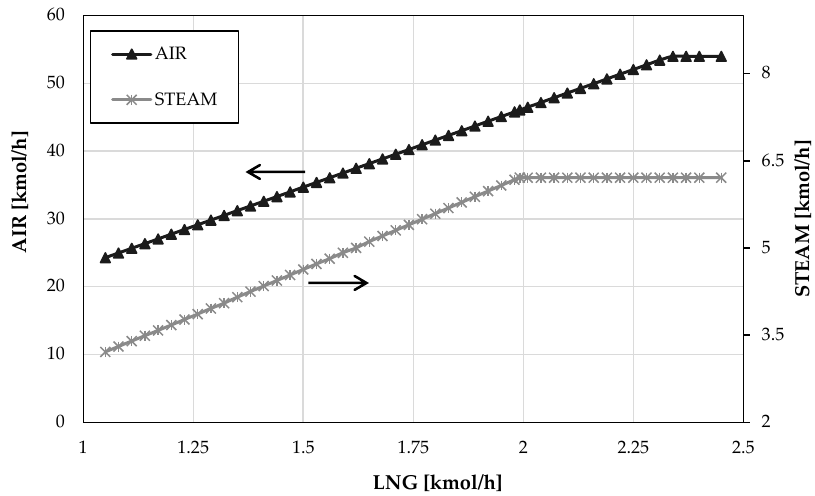
Figure 8. Effect of the LNG stream variation on air inlet stream and the steam production. Table 8. Adjusted heat balance of the cruise ship with the SOFC power plant integrated with the heat recovery system.